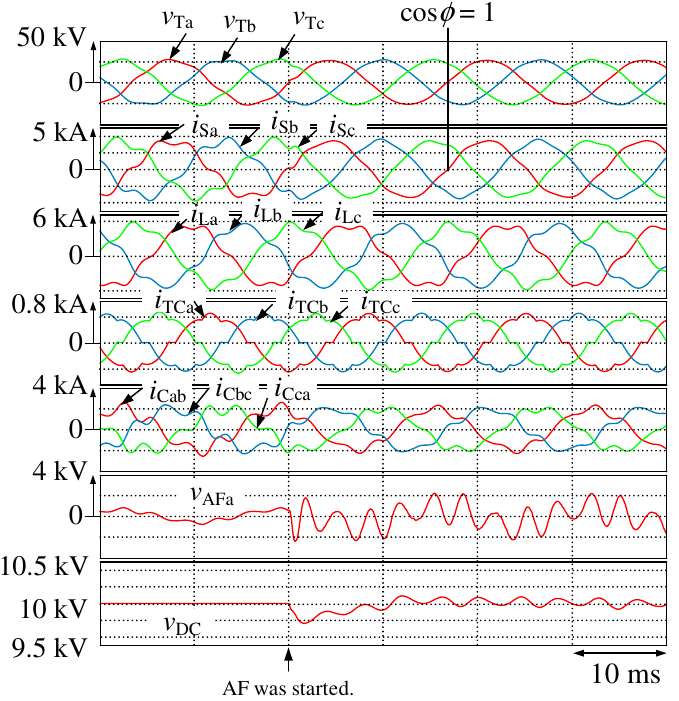
Figure 8. Simulation waveforms for Figure 4 before/after the series active filter (AF) with K C of 20 Ω was